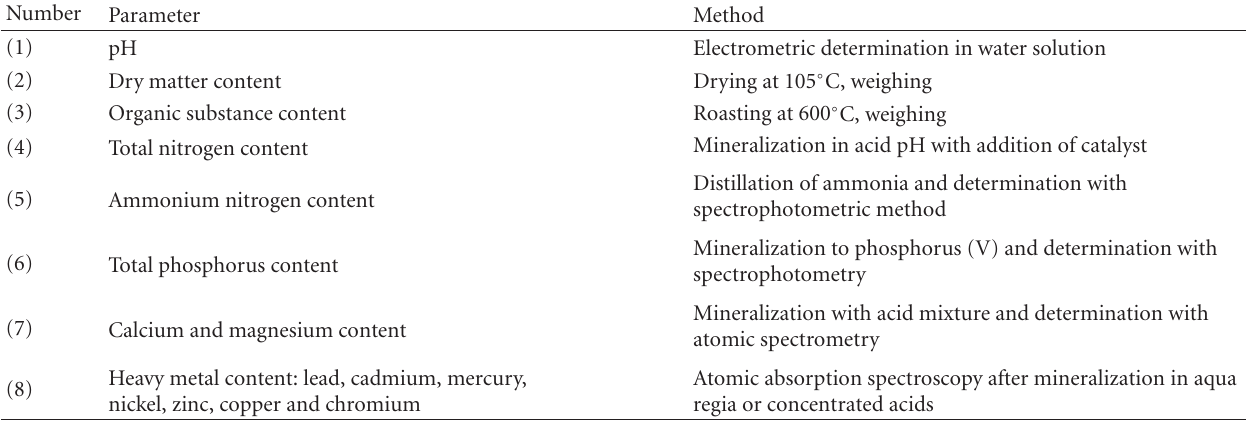
Table 1: Applicable reference methods of municipal sewage sludge research